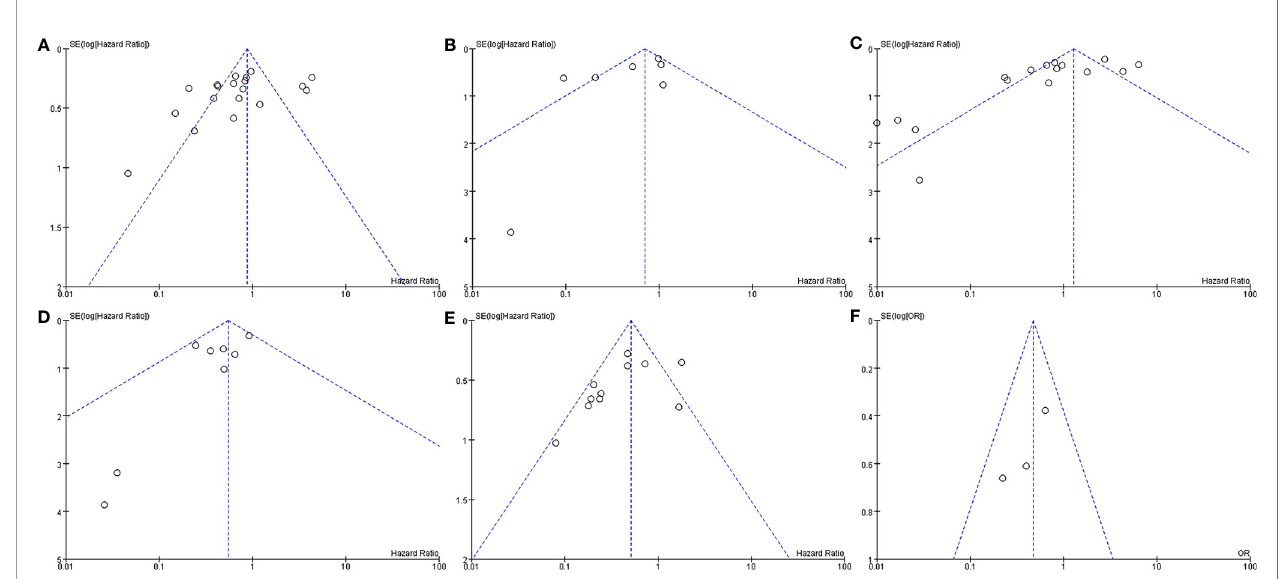
FIGURE 3 | Funnel plot. Surgery+RT vs Surgery, PFS (A) . Surgery+RT vs Surgery, OS (B) . GTR+RT vs GTR, PFS (C) . GTR+RT vs GTR, OS (D) . STR+RT vs STR, PFS (E) . STR+RT vs STR, OS (F)